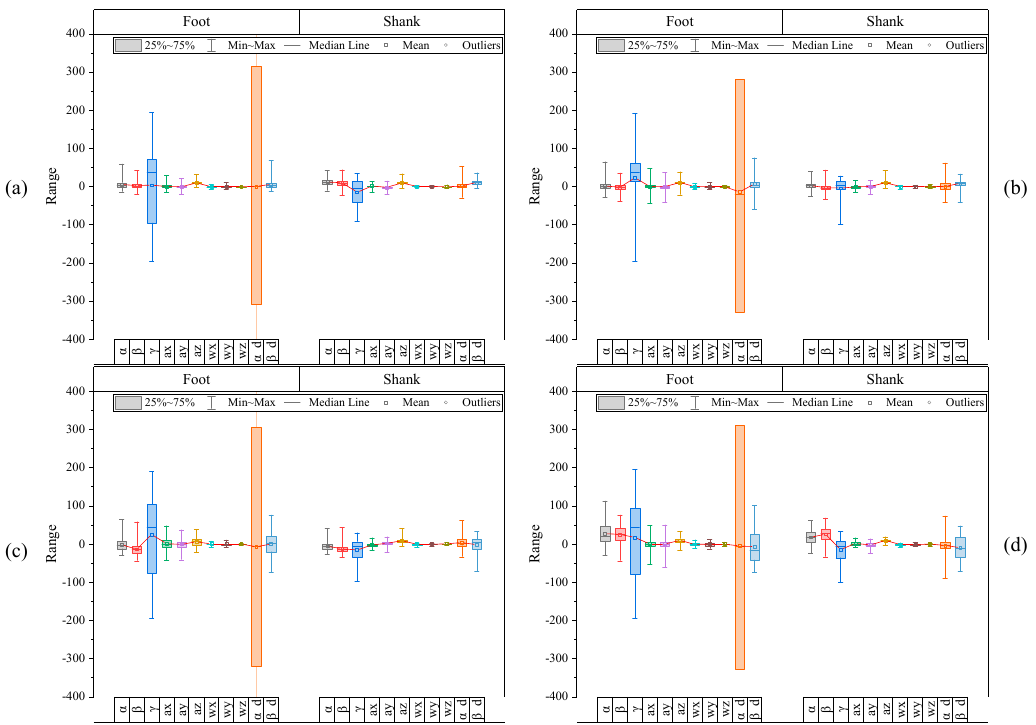
Figure 11. Box plot results of the augmented raw feature dataset with mean, standard deviation for each label, ( a ) label 2, ( b ) label 3, ( c ) label 4, ( d ) label 5.